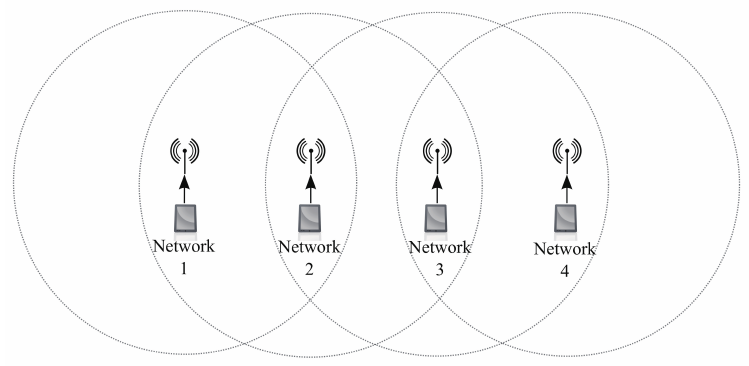
Figure 3. Carrier-sensing range of each network in